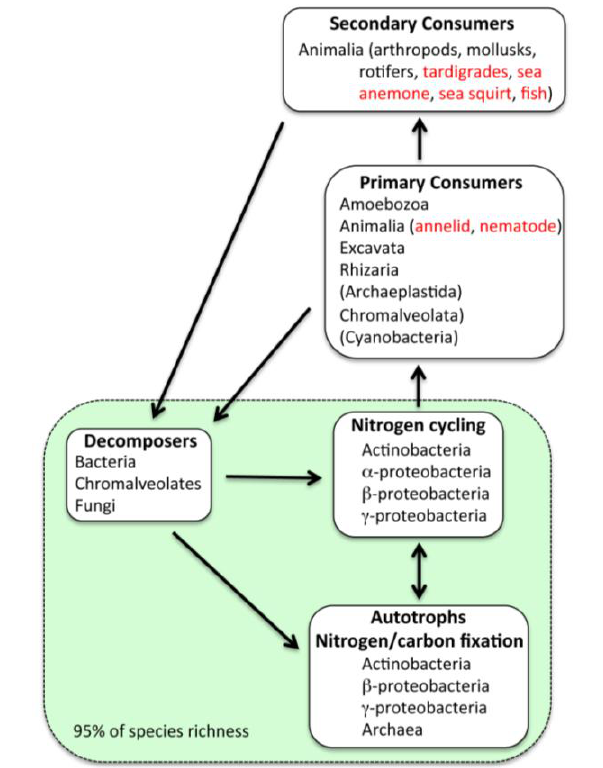
Figure 3. Ecological characterization of organisms based on BLAST search results from the V5 and V6 metagenomic/metatranscriptomic sequences. The taxonomic classifications listed are based on the highest identities to sequences from species within the taxa that have been documented to have the functions specified in the boxes. These have been grouped primarily by Phylum for simplicity. Greater than 95% of the taxa are either primary producers (autotrophs), bacteria involved in the nitrogen cycle, or decomposers, including bacteria and fungi, and a few chromalveolates (shaded green box). Primary and secondary consumers comprise less than 5% of the species richness ( i.e. , number of unique sequences). Organisms listed in black font were determined by sequences that exhibited (cid:149)(cid:28)(cid:26)(cid:8)(cid:3)(cid:86)(cid:72)(cid:84)(cid:88)(cid:72)(cid:81)(cid:70)(cid:72)(cid:3)(cid:76)(cid:71)(cid:72)(cid:81)(cid:87)(cid:76)(cid:87) y with sequences in GenBank (NCBI). Organisms listed in red font exhibited <97% sequence identity or were suggested because the sequences were closest to symbionts, parasites or pathogens of those organisms (cid:11)(cid:68)(cid:87)(cid:3)(cid:149)(cid:28)(cid:26)(cid:8)(cid:3)(cid:86)(cid:72)(cid:84)(cid:88)(cid:72)(cid:81)(cid:70)(cid:72)(cid:3)(cid:76)(cid:71)(cid:72)(cid:81)(cid:87)(cid:76)(cid:87)(cid:92)(cid:12)